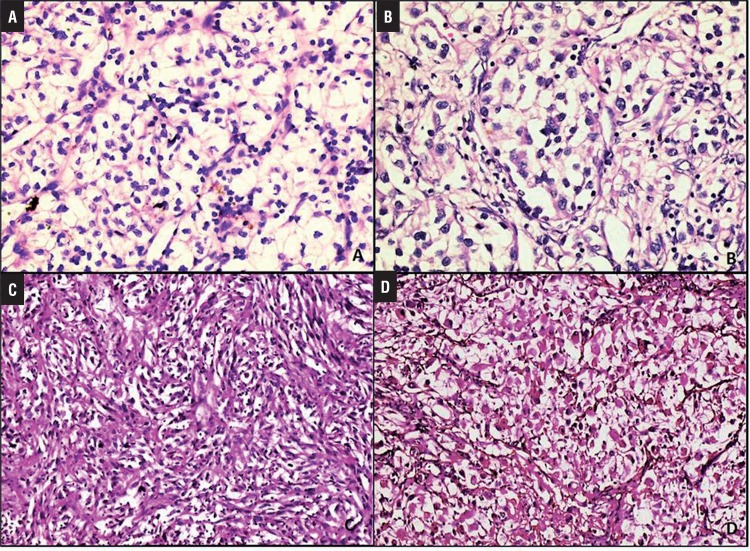
Microscopic features of clear cell renal cell carcinomas. A) Fuhrman grade 1 tumor (H&EX100), B) Fuhrman grade 3 tumor (H&EX200), C and D) Sarcomatoid differentiation in clear cell renal cell carcinoma (H&EX50).